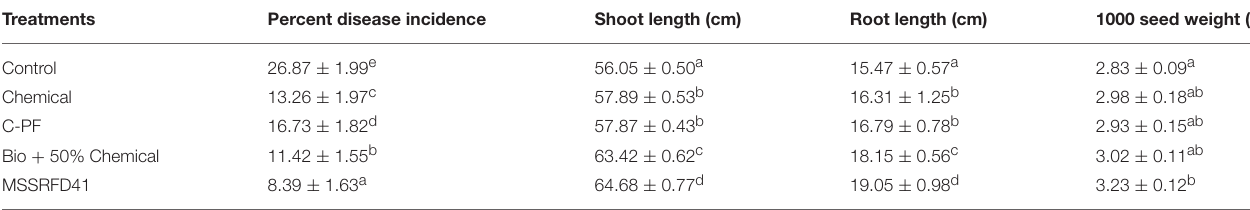
TABLE 6 | Field efficacy of Pseudomonas sp. MSSRFD41 in the control of P. grisea and growth promotion of finger millet. Treatments